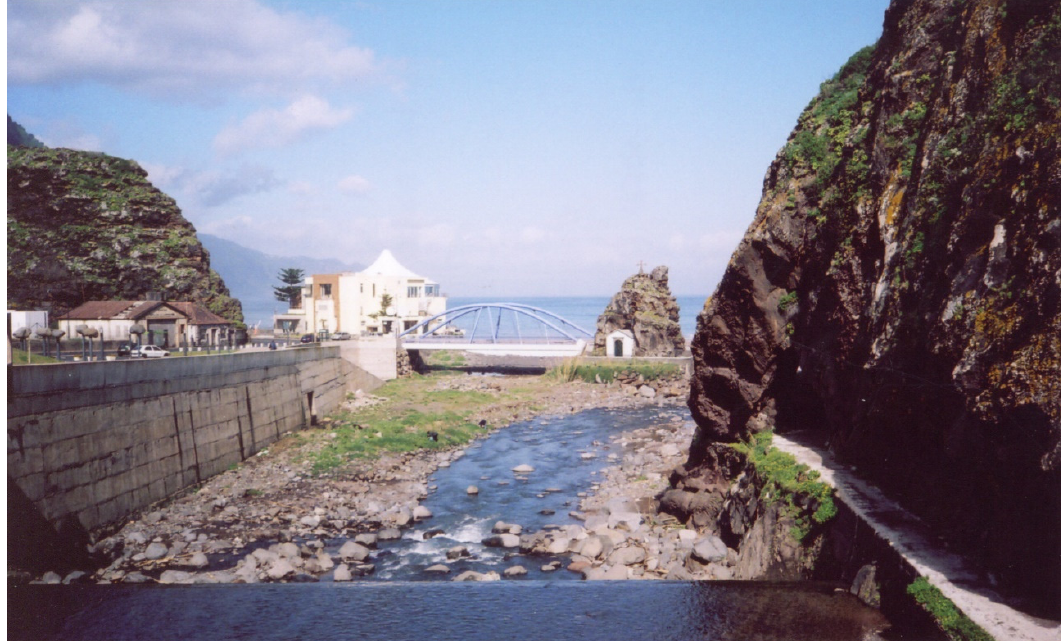
Figure 1. The São Vicente watershed. (Source: Authors by ESRI ArcGIS, 2020).